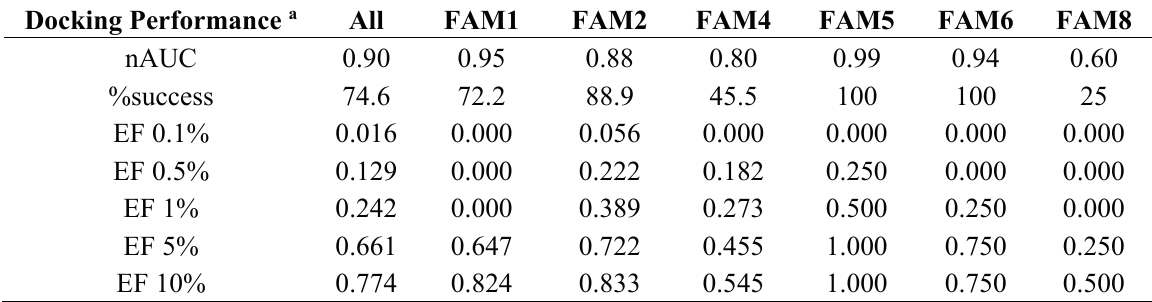
Table 4. nAUC, %success and EF of 3FMH_3FMK_3QUE_4DLJ ensemble. Docking Performance